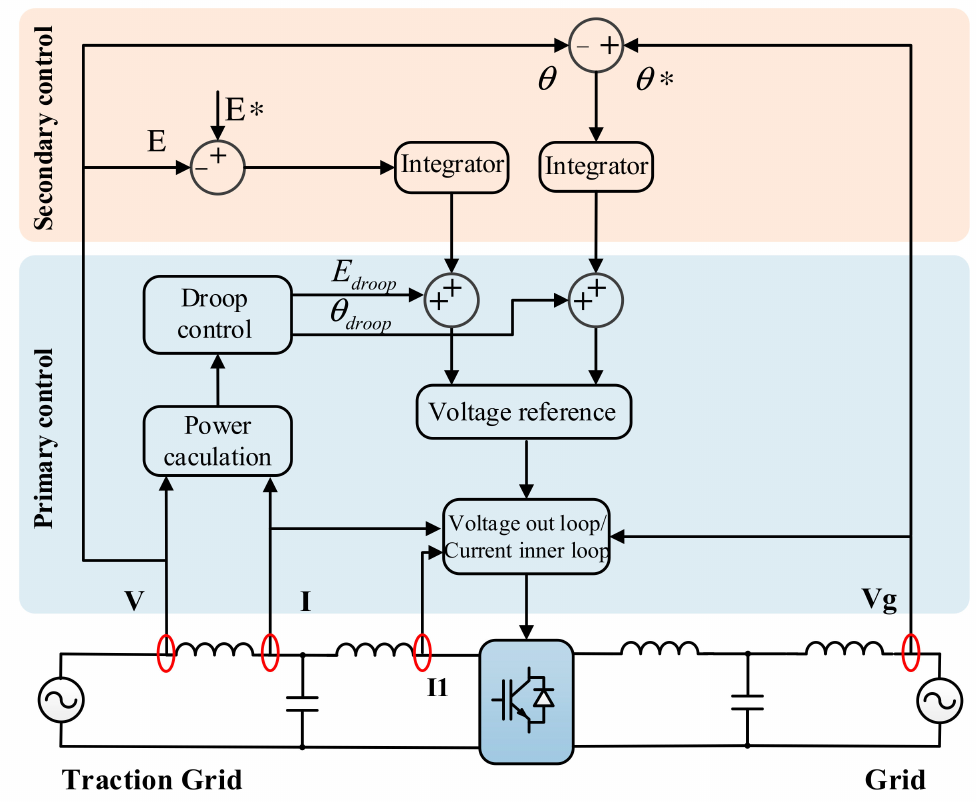
Figure 2. The proposed decentralized control strategy for the substation in the traction microgrid.